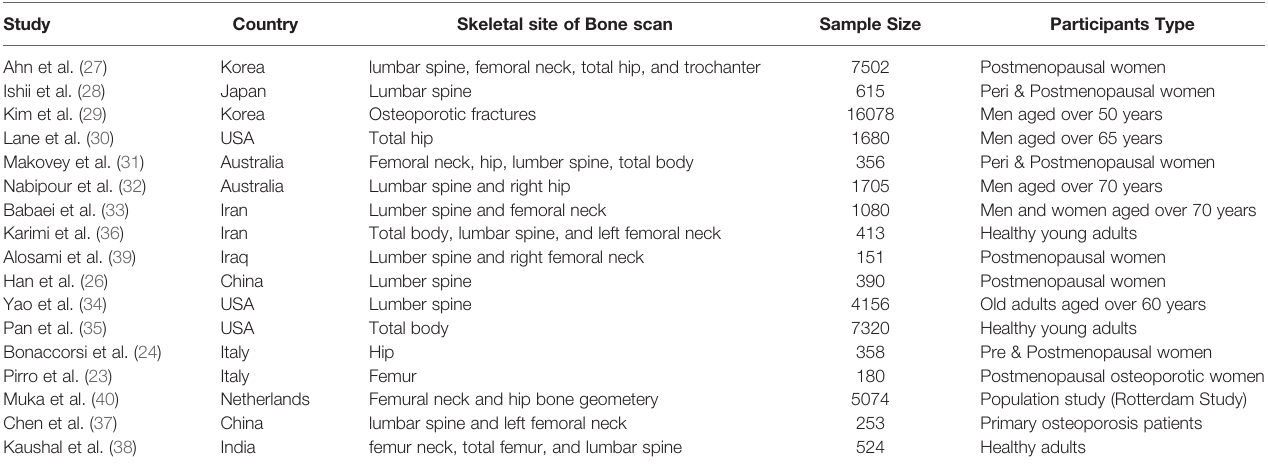
TABLE 2 | Studies with a positive association between SUA and BMD in different study designs and